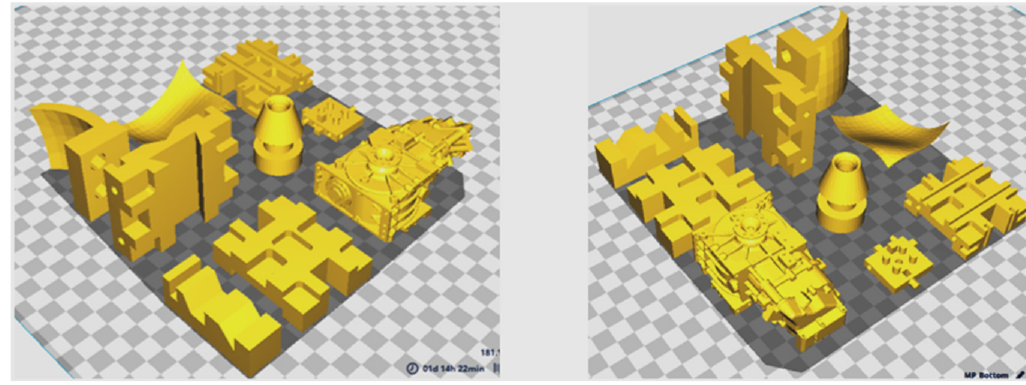
Figure 7. Components in two different random orientations on the build